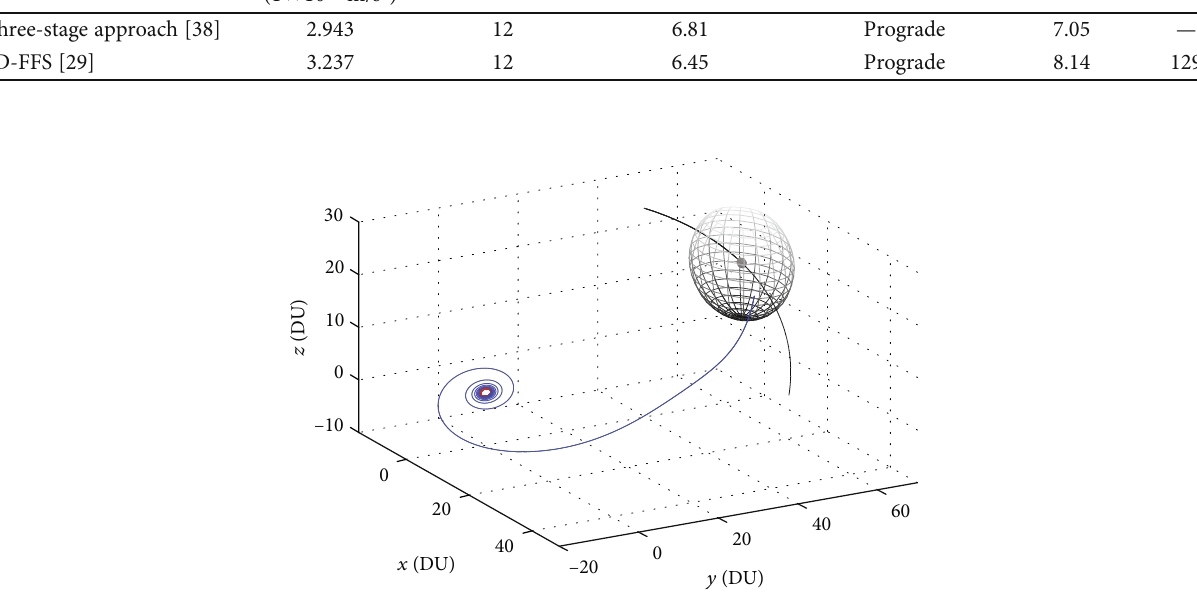
Figure 18: Geocentric section of Earth-Moon transfer trajectory.